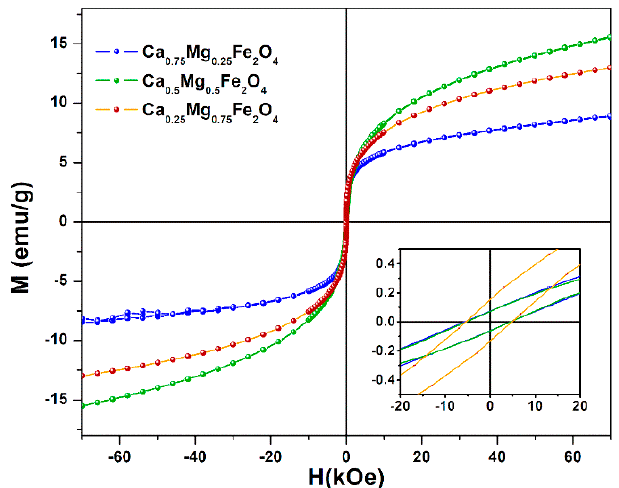
Figure 5. Magnetization hysteresis loops of calcium-substituted magnesium ferrite nanoparticles measured at room temperature. Inset: Enlargement of the loops in the low field region.